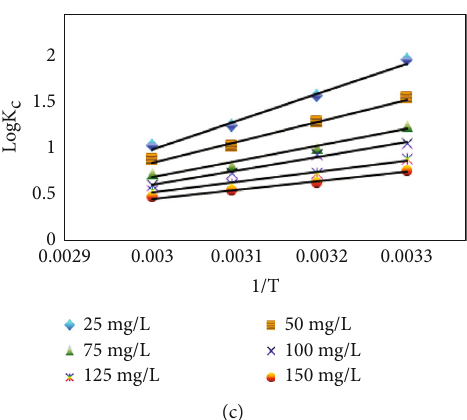
Figure 5: (a) Isotherm fi t for the adsorption of MG dye onto UAES. (b) Kinetic fi t for the adsorption of MG dye onto UAES. (c) Thermodynamic study for the adsorption of MG dye onto UAES. Table 2: Assessment of q m value of UAESP with the previously used materials for MG dye adsorption. S. no.